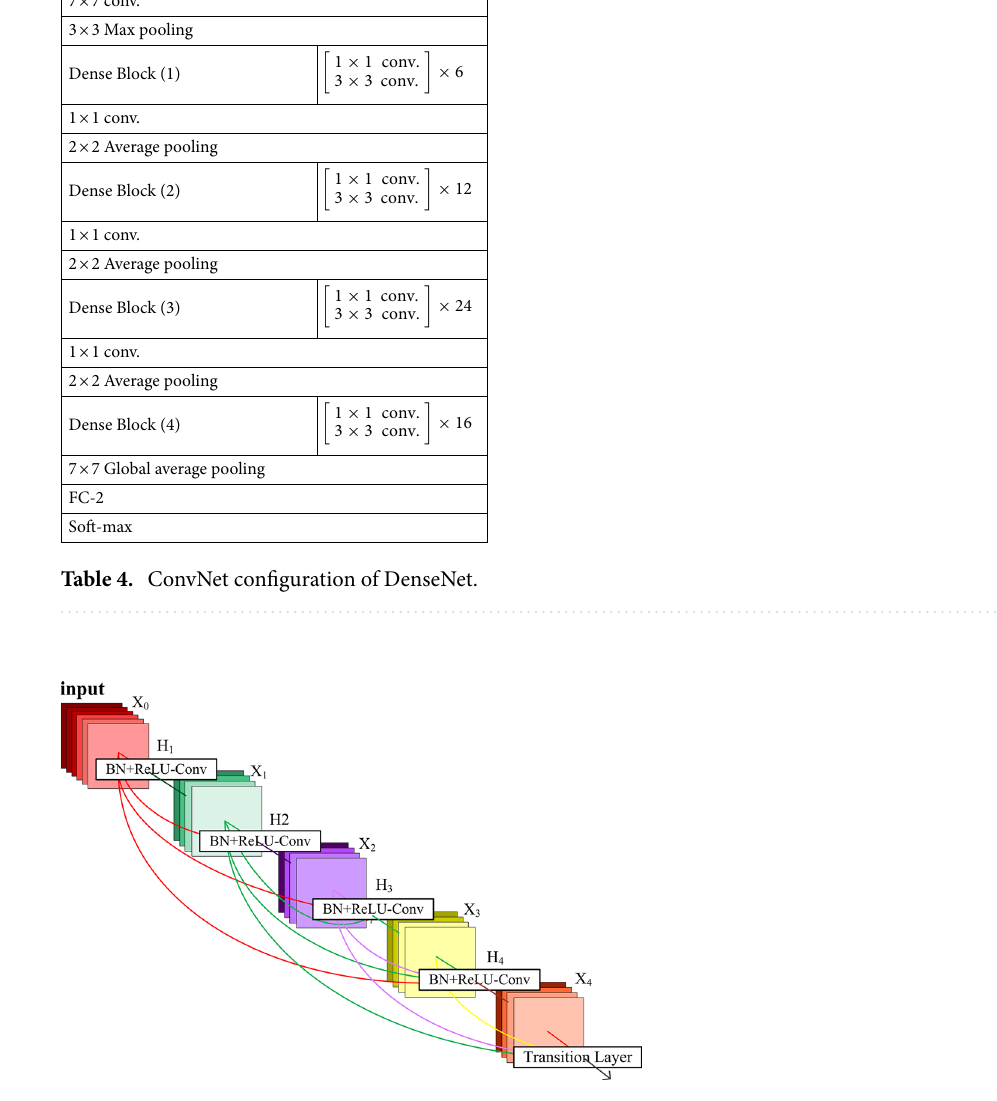
Figure 7. The structure of dense block in DenseNet-121